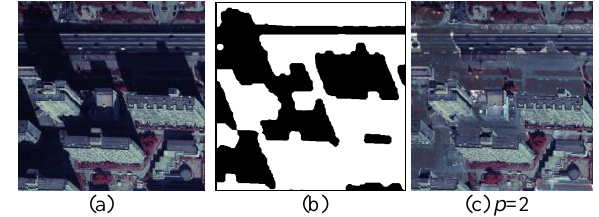
Figure 4. Color infrared aerial image (a) the shadow detection result (b) and the results of shadow removal (c) Using the same method as 5.1, the brightness, contrast and average gradients are calculated separately in the shadow and non-shadow regions. Table 2 is the result. Figure 5 includes three statistical trend charts of the shadow region, when p is from 1 to 10 in shadow removal processing.